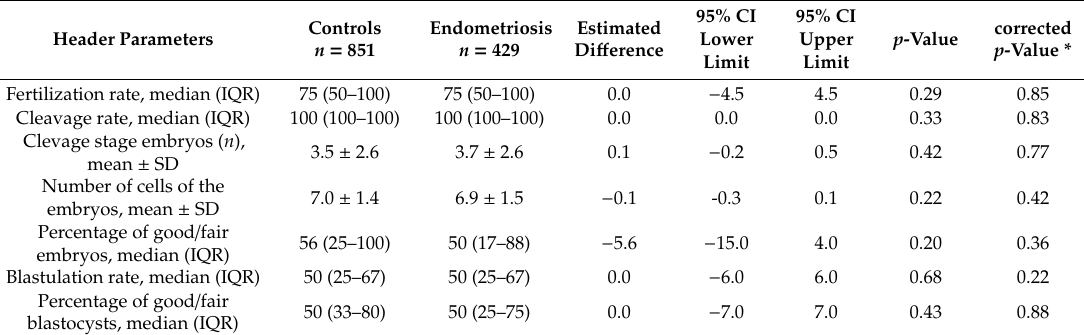
Table 2. ART outcomes in the two studied